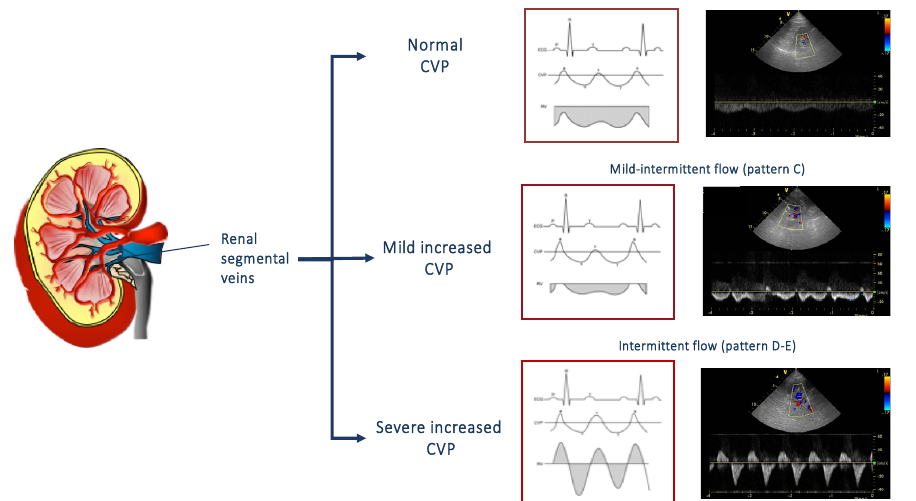
Figure 3. On the right, renal venous patterns evaluated by means of pulsed Doppler at the level of segmental renal veins. In presence of normal central venous pressure, a continuous flow can be observed (top). A mild intermittent (middle) or an intermittent pat-tern (bottom) can be observed according to the presence of a mild or severe increase of central venous pressure. CVP: central venous pressure.